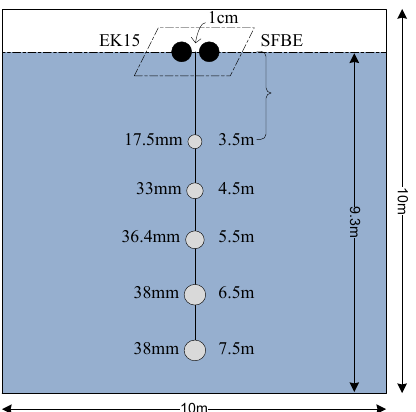
Figure 19. Experimental setup for the second experiment. Five spheres were tied together by a string with a separation of 1 m.